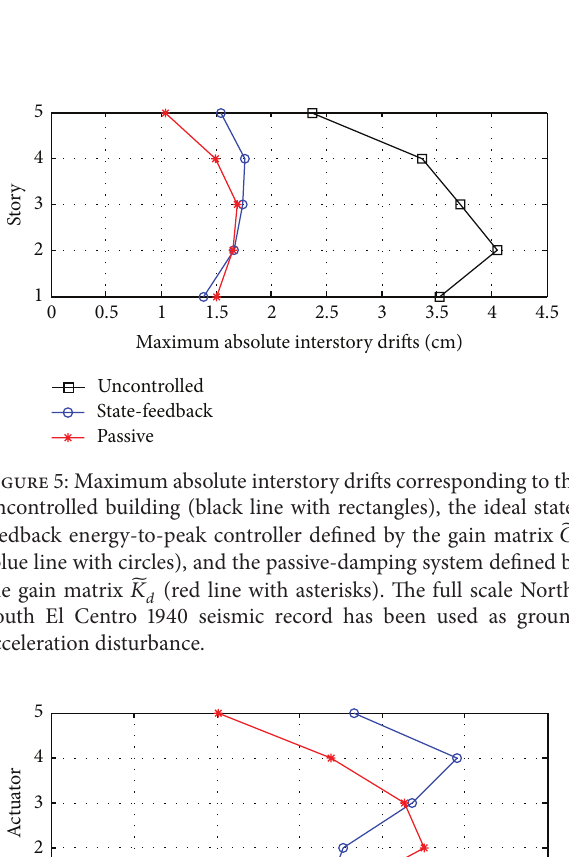
Figure 6: Maximum absolute control efforts corresponding to the ideal state-feedback energy-to-peak controller defined by the gain ̃𝐺 matrix 𝑠 (blue line with circles) and the passive-damping system ̃𝐾 defined by the gain matrix 𝑑 (red line with asterisks). The full scale North-South El Centro 1940 seismic record has been used as ground acceleration